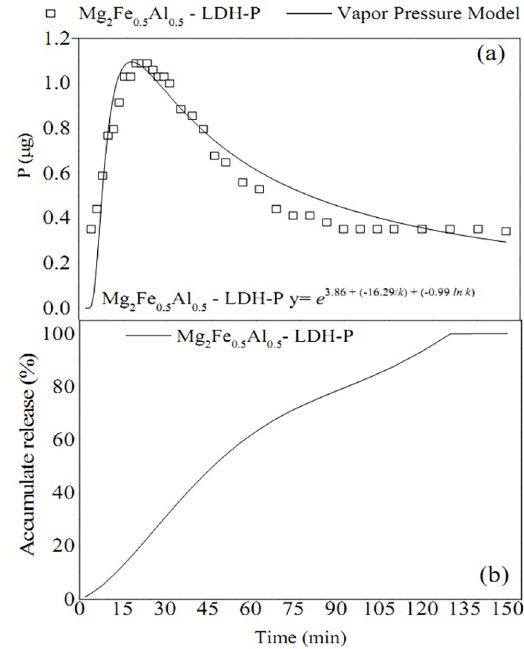
Figure 7. P release in solution of Mg in relation to the time. (a) release profile, (b) cumulative rate release.